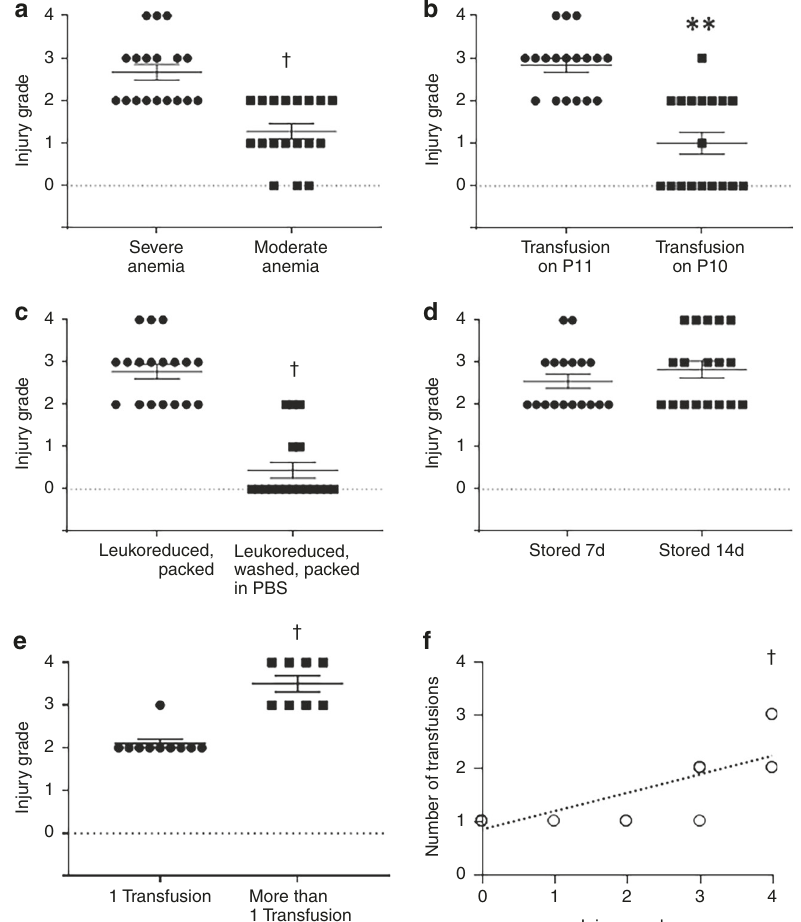
Fig. 9 Clinical variables relevant in transfusion-associated necrotizing enterocolitis (NEC). Scatter plots show severity of NEC-like injury (means ± standard error) following: a red blood cell (RBC) transfusions in mice with severe (hematocrit 20 – 24%) vs. moderate anemia (hematocrit 25 – 30%); b transfusions administered soon after the hematocrit dropped to 20 – 24% (on P10) vs. 24 h later (P11); c transfusions with leukoreduced, packed RBCs vs. RBCs that were leukoreduced, washed, and resuspended in phosphate-buffered saline (PBS) before storage; d transfusions with RBCs stored for 7 vs. 14 days; e single vs. multiple RBC transfusions. N = 18 mice per group in all above experiments; Mann – Whitney U test, ** P < 0.01, † P < 0.001. f Scatter plot shows positive correlation (Spearman ’ s r = 0.865) between number of transfusions and severity of injury; † P < 0.001. All error bars show standard error of the